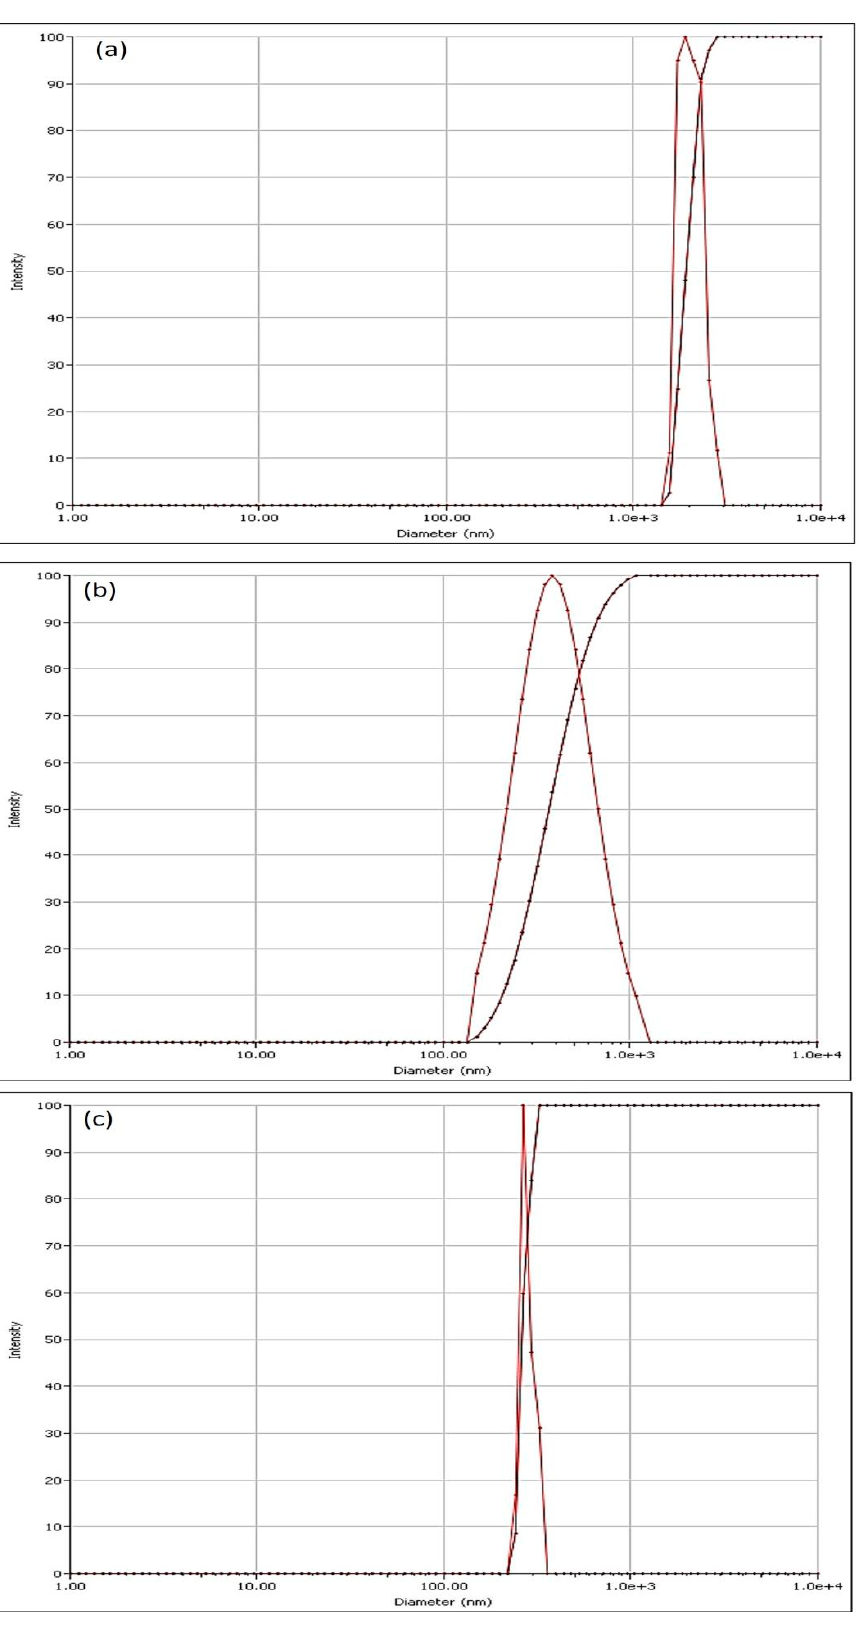
Figure 9. DLS image of titanium nanoparticles formed by: ( a ) Bacillus subtilis , ( b ) Cassia fistula and ( c ) hydrothermal heating showing size and shape.